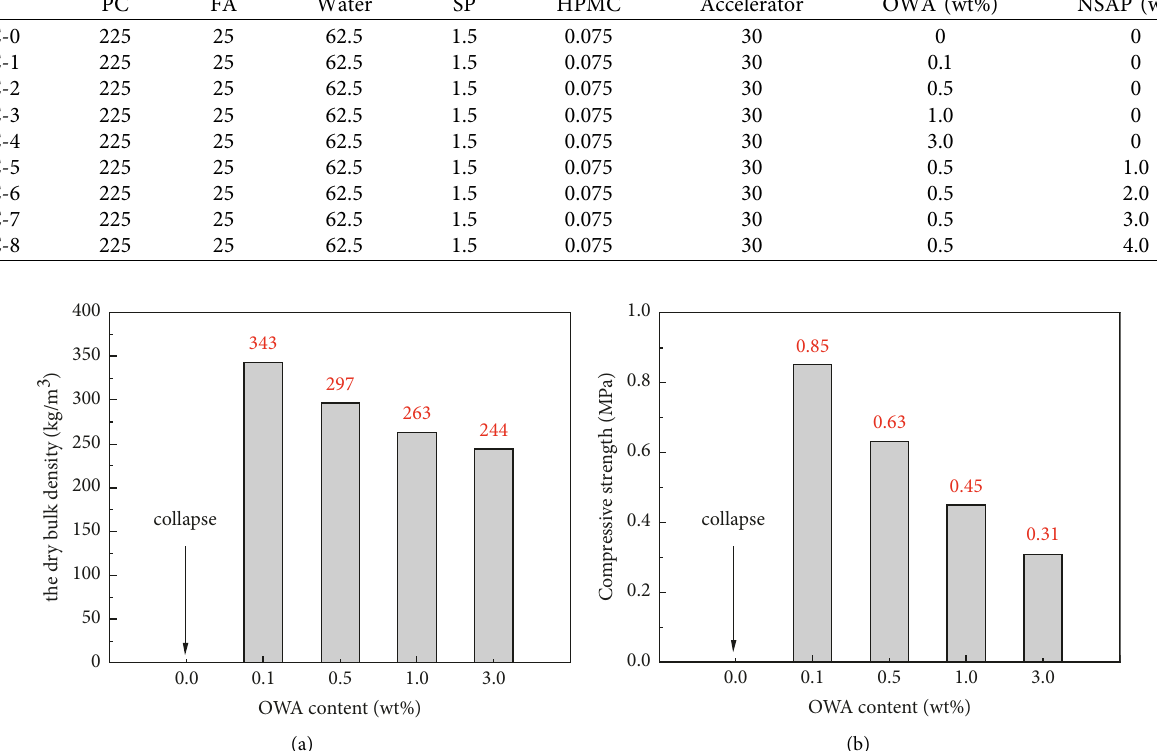
Figure 1: Effect of different OWA content on (a) dry bulk density and (b) compressive